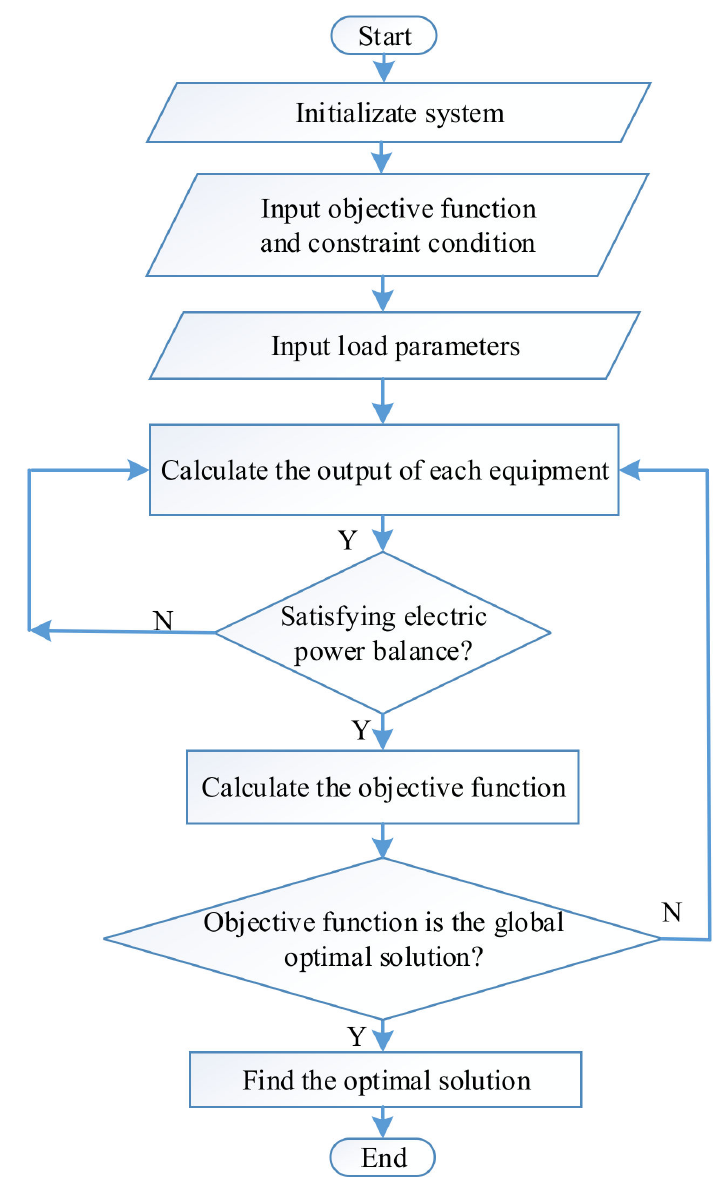
Figure 5. Flow chart of optimal scheduling